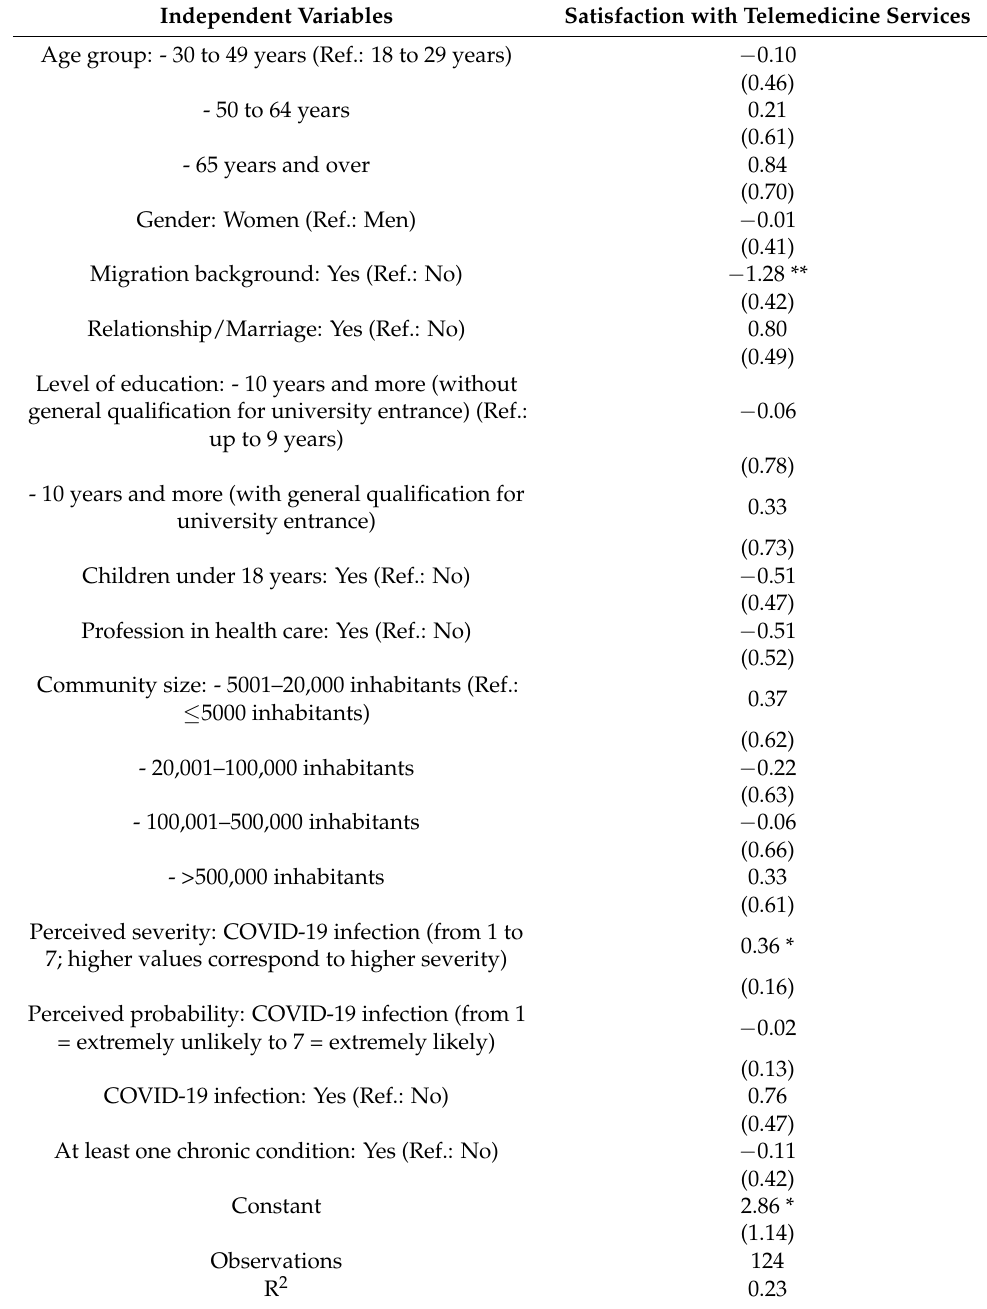
Table 3. Correlates of satisfaction with telemedicine services (from 1 = very dissatisfied to 7 = very satisfied). Findings of multiple linear